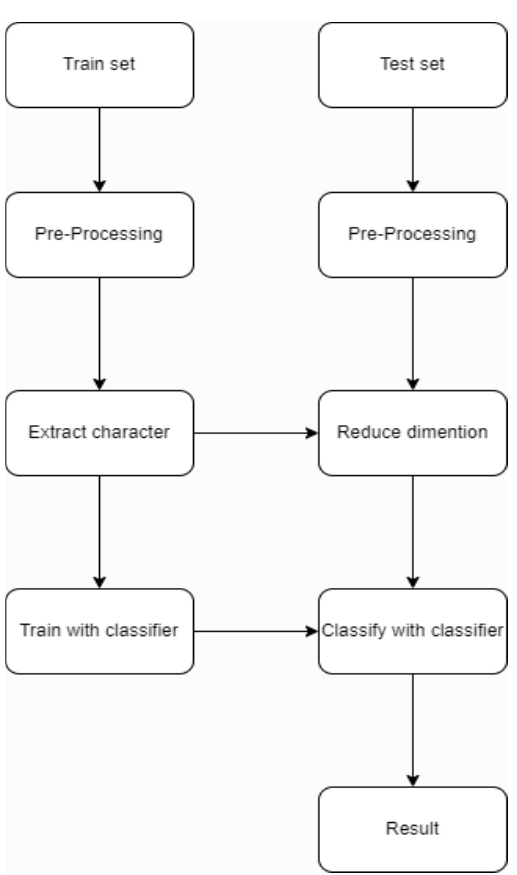
Figure 1. Preprocessing on the dataset Figure 1. shows the analytical process hijja data set. The dataset was split for train and test information in which 80% of data was allocated to the train data and 20% for test